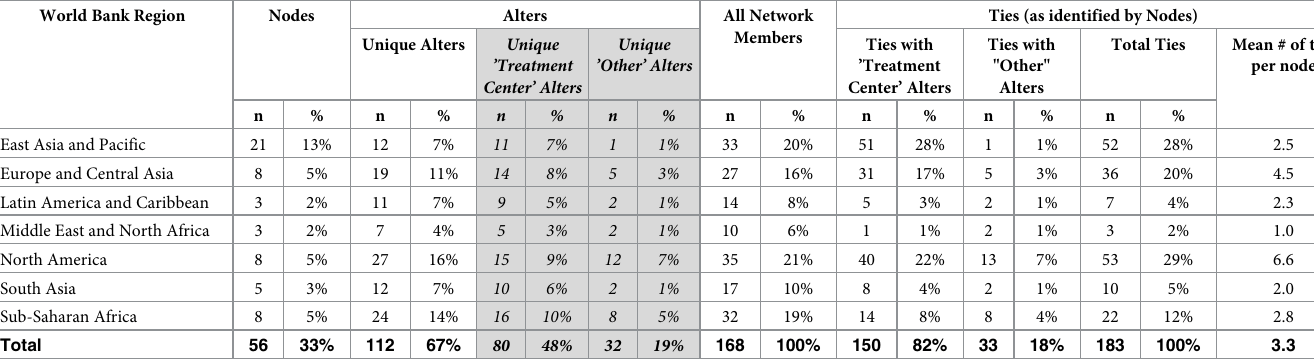
Table 1. Nodes, alters and ties by world bank region. World Bank